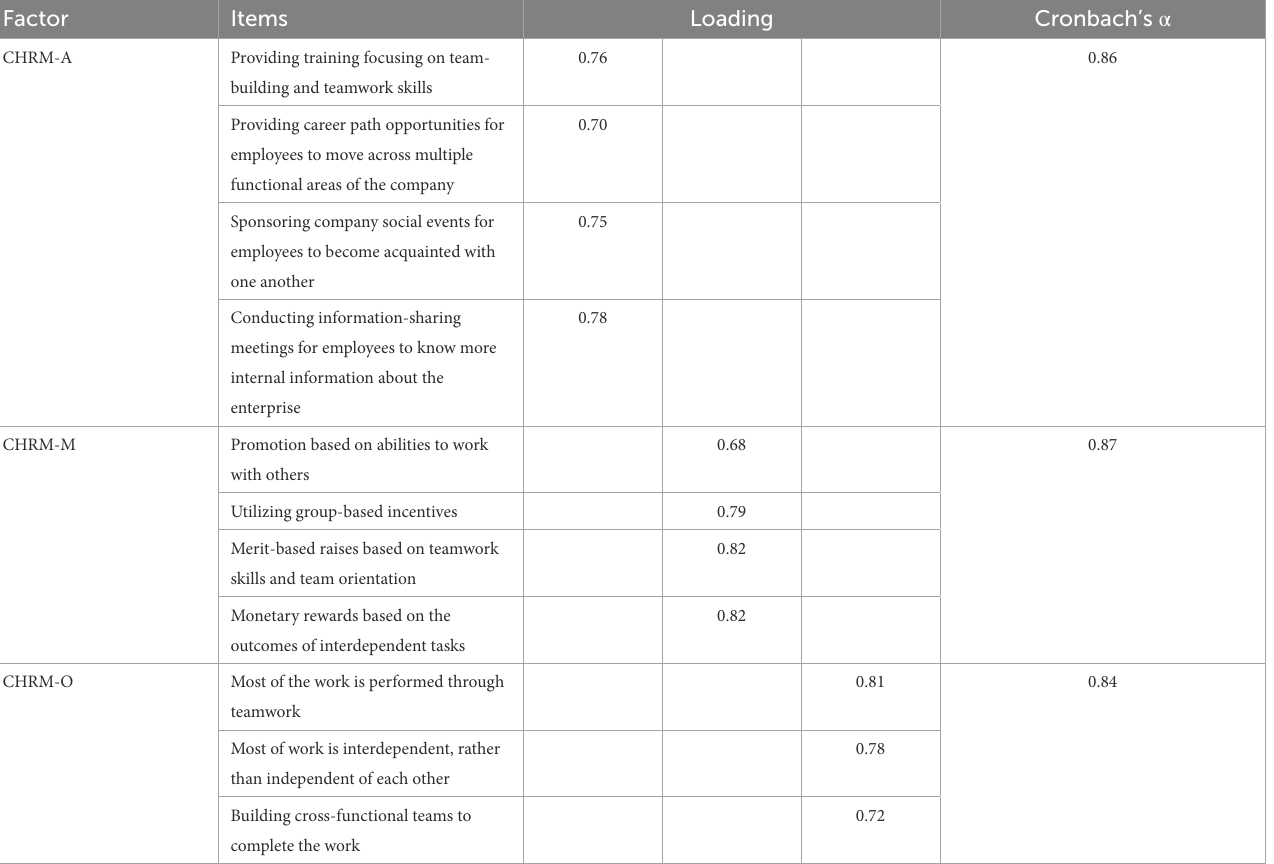
TABLE 1 The results of exploratory factor analyses for collaborative HRM.